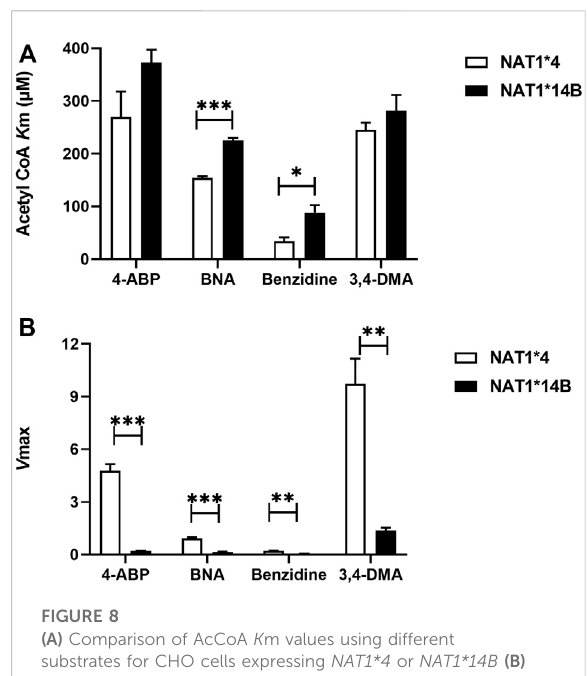
FIGURE 8 (A) Comparison of AcCoA K m values using different substrates for CHO cells expressing NAT1*4 or NAT1*14B (B) Comparison of V max values (nmol/min/mg) using different substrates for CHO cells expressing NAT1*4 or NAT1*14B. Data represents Mean ± S.E.M. of three separate experiments (* p < 0.05, ** p < 0.01, *** p <